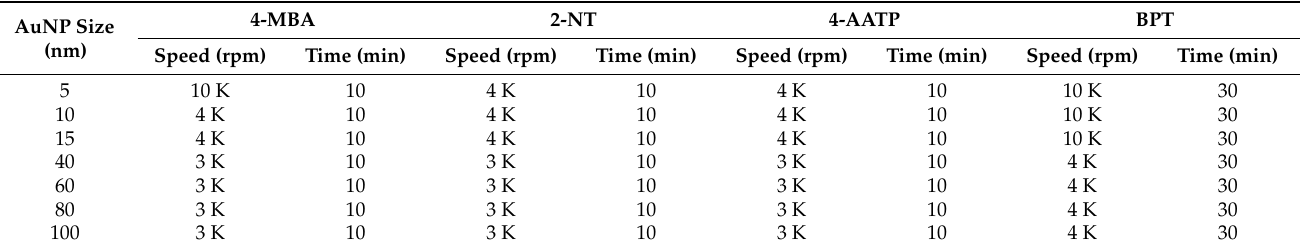
Table 1. Centrifugation rate and time used in the preparation of labeled gold nanoparticle